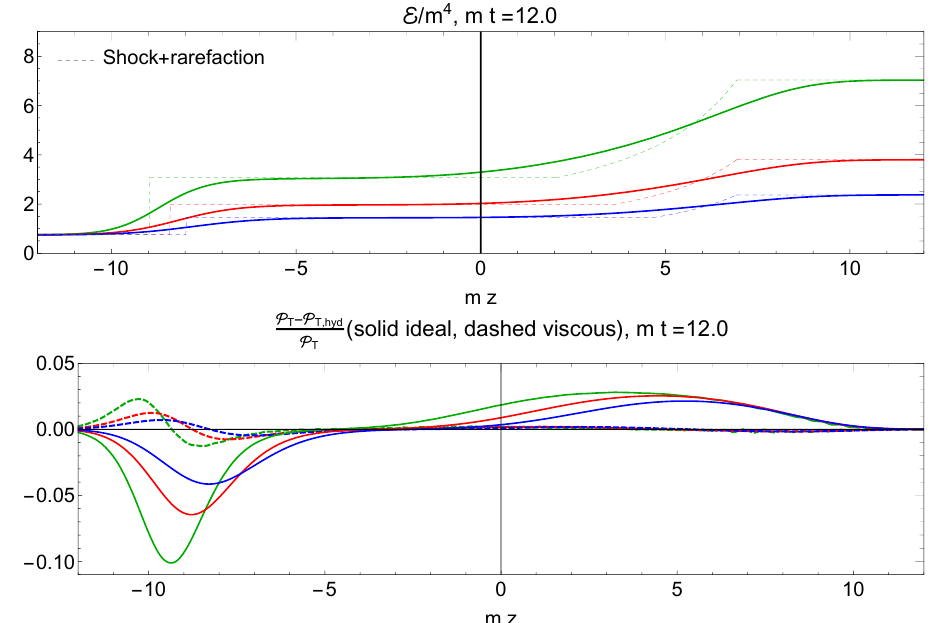
Figure 12: (top) Energy density for different heat bath temperature ratios together with the shock + rarefaction from Section 2 (dashed). (bottom) Comparison with ideal (solid) and viscous (dashed) hydrodynamics. For larger ratios ideal hydrody- namics becomes a worse description for the rarefaction wave, though viscous hy- drodynamics is applicable. The shock region has increasingly large deviations from viscous hydrodynamics as the ratio is